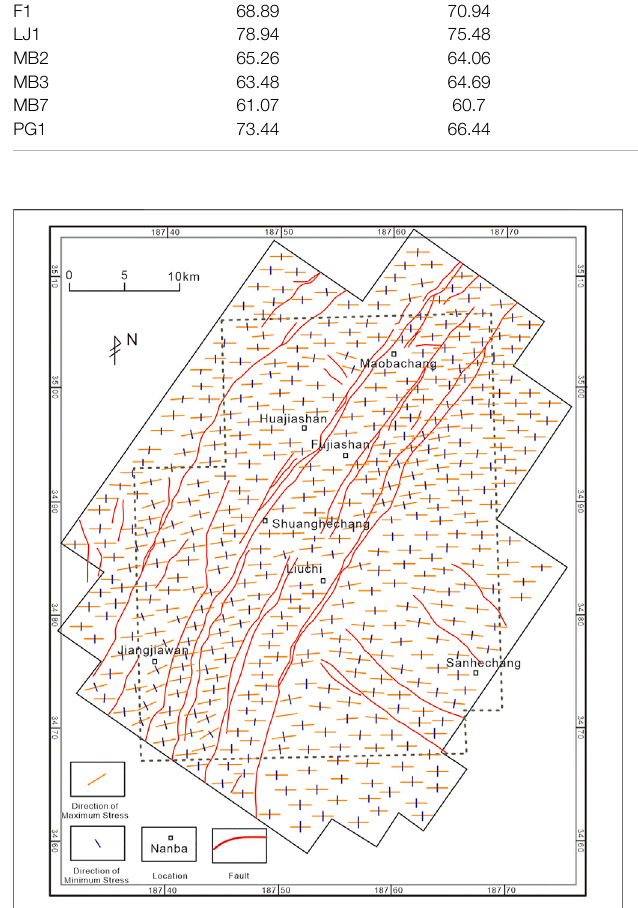
FIGURE 3 | The distribution map of geo-stress directions in the second member of Jialingjiang formation, Puguang area.